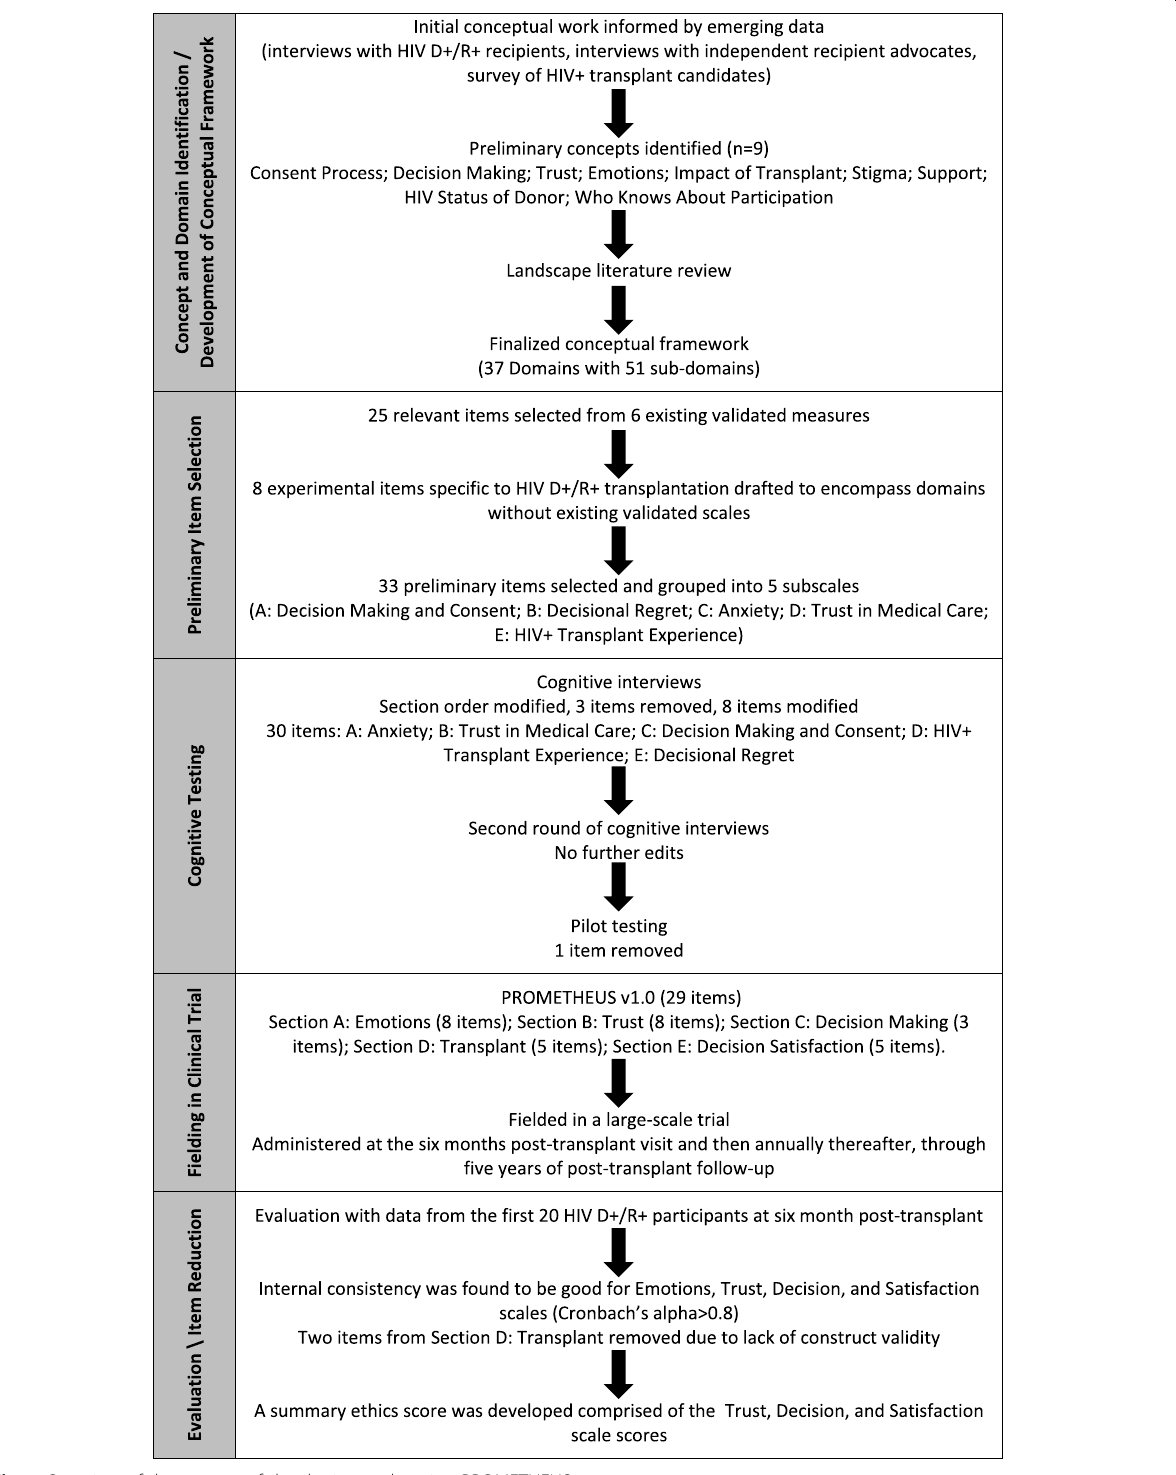
Fig. 1 Overview of the process of developing and testing